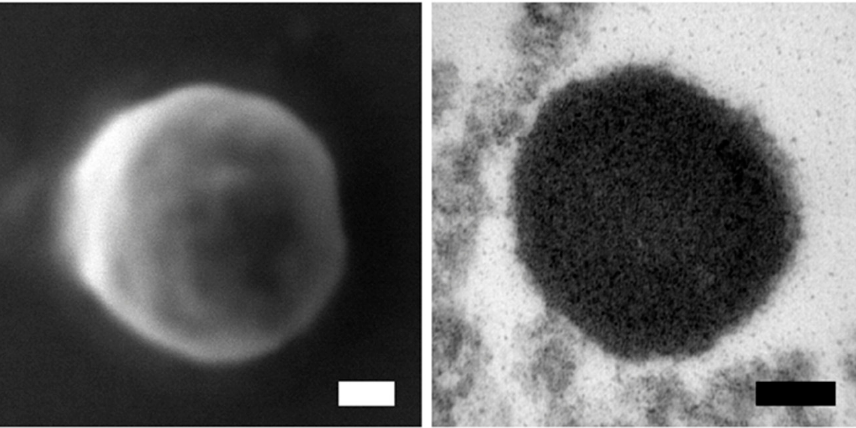
Figure 1. Field emission scanning electron microscopy (FESEM) micrographs of a truncated version of recombinant matrix Metalloproteinase-9 (rtMMP-9) IBs ( left panel ) and transmission electron microscopy (TEM) micrographs of rtMMP-9 IBs ( right panel ). Scale bars: 100 nm.